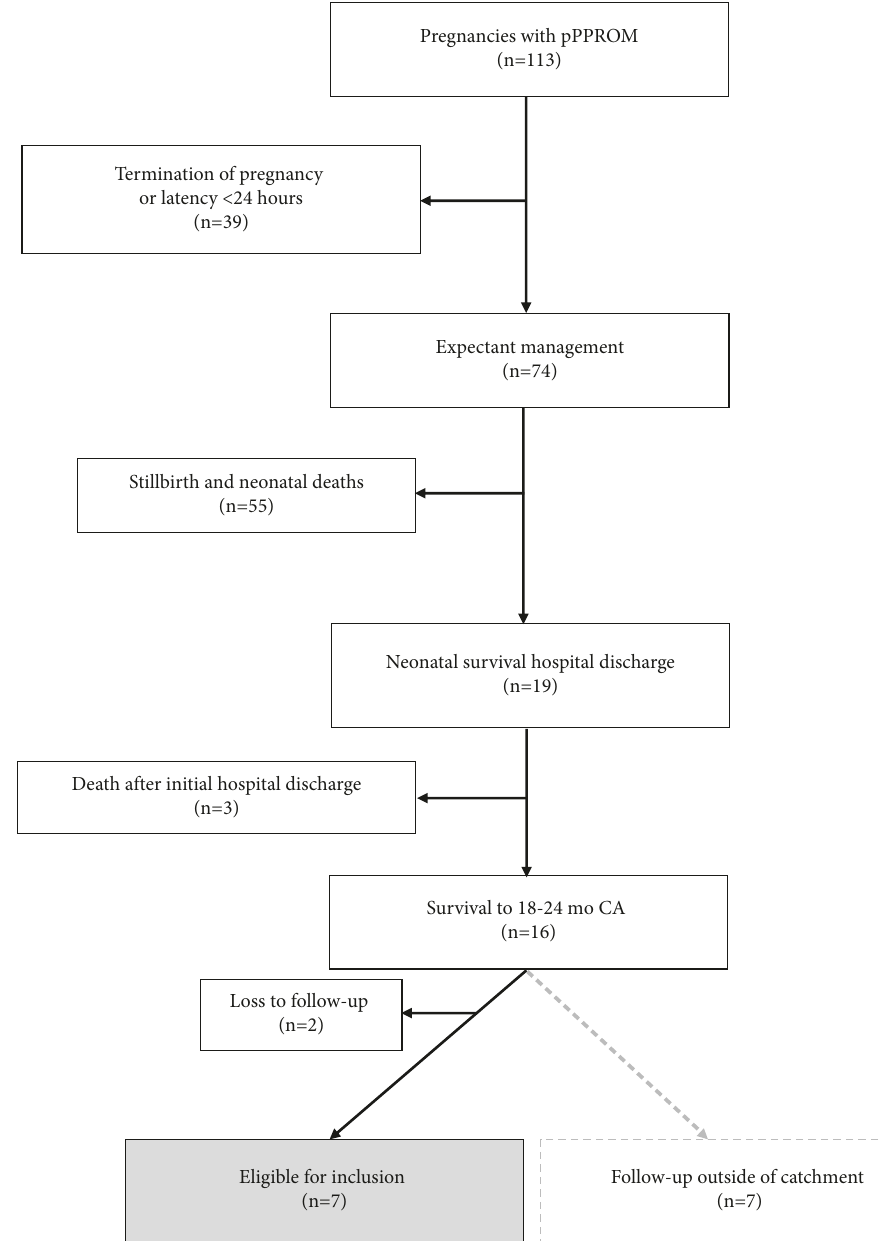
Figure 1: Flowchart of patients included in the study. pPPROM, previable preterm prelabour rupture of membranes; CA, corrected